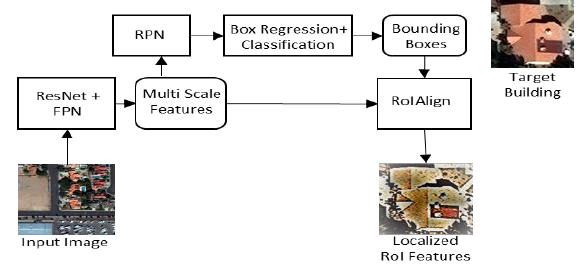
Figure 2. Backbone